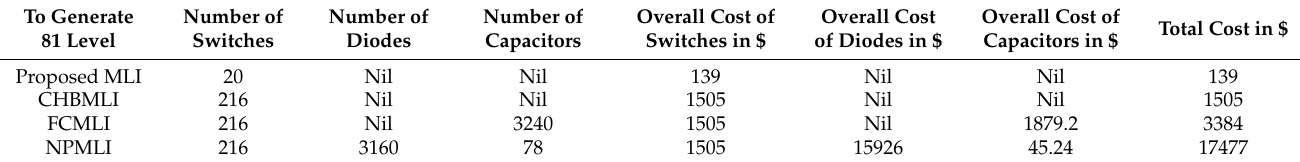
Table 7. Unit price of the circuit components. Table 8. Cost-benefit analysis of 81-level SLMLI with conventional